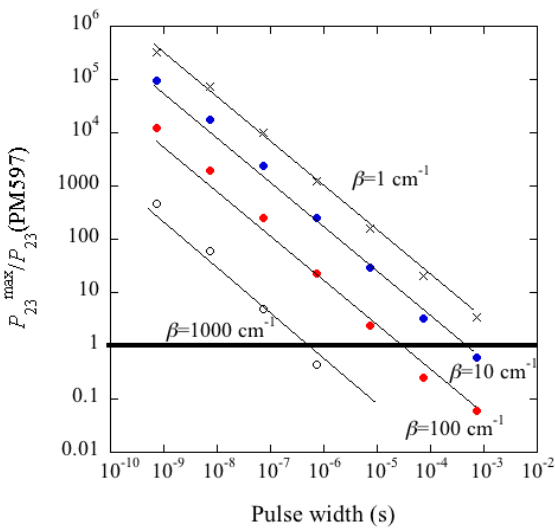
Figure 11. Maximum P 23 values allowing for lasing action in a 13 µ m thick CLC sample doped with PM597 (1 wt %) as a function of the pumping pulse width. P 23 values are scaled relative to the actual P 23 value for PM597. The different symbols correspond to different β values. Continuous lines are fits ≈ A / (cid:0) ∆ τ p (cid:1) δ to a law P max 23 .